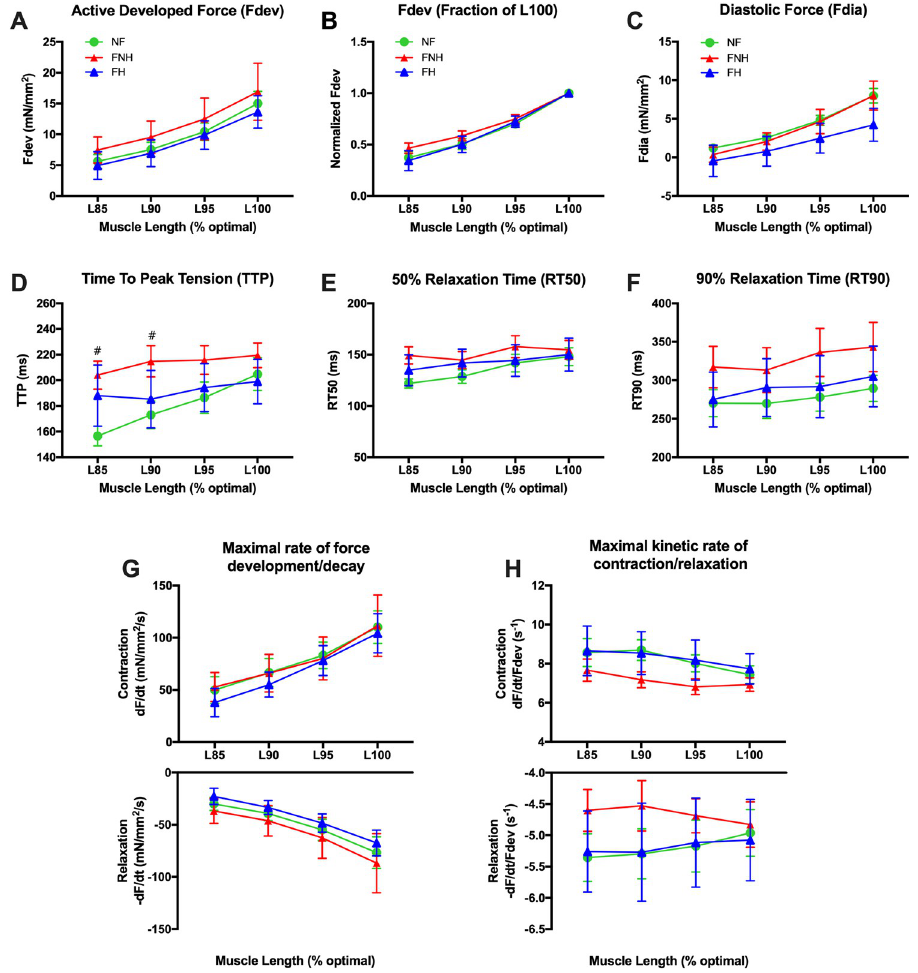
Fig 2. Length-dependent activation in NF trabeculae ( n = 9) vs. failing trabeculae with no hypothyroidism (FNH; n = 9) and failing trabeculae with hypothyroidism (FH; n = 4). (A) Length dependent force development was virtually identical in all groups. (B) Same data as panel A, plotted to each muscle’s individual maximum to allow equal weight of each muscle in the statistical analysis. (C) F dia increased by increasing the muscle length, and there was no difference in the degree of change in force between the three groups in response to length increase. (D) TTP in NF myocardium was markedly slowed down as muscle length increased rather than the two failing groups, while trabeculae isolated from FNH hearts showed a prolonged TTP overall different muscle lengths compered to both NF and FH hearts and became significantly different compared to NF at L 85 ( P = 0.013) and L 90 ( P = 0.032). (E) RT50 decreased as muscles were shortened from L 100 to L 85 and the degree of shortening was much obvious in NF group. (F) RT90 was not significantly different between the three groups at each respective muscle length and was faster as muscles were shortened. (G) +dF/dt and -dF/dt were prolonged in NF and failing groups as muscles were shortened and were not significantly different between groups. (H) + dF/dt/F dev was sped up as muscles were shortened with no difference between groups. With the exception of trabeculae isolated from FNH hearts, -dF/dt/F dev was also sped up in both NF and FH groups. Data are depicted as means ± SEM; A two-way repeated measures ANOVA followed by Tukey’s post hoc test for multiple comparisons; � indicates P < 0.05 significant difference between NF and FH groups; # indicates P < 0.05 significant difference between NF and FNH groups at corresponding muscle length. L100, optimal muscle length; L85, 85% of L100; L90, 90% of L100; L95, 95% of L100; other abbreviations as in Fig